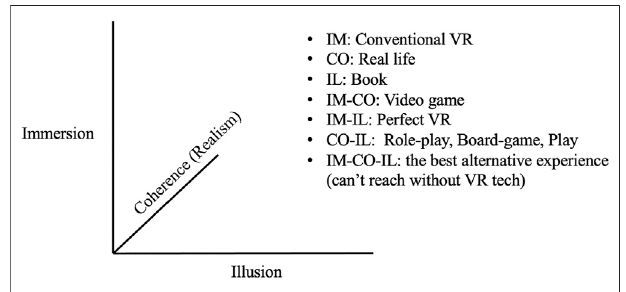
FIGURE 1 | Model for Quality of VR Experience using Orthogonal Dimensions of Coherence (CO), Immersion (IM), and Illusion